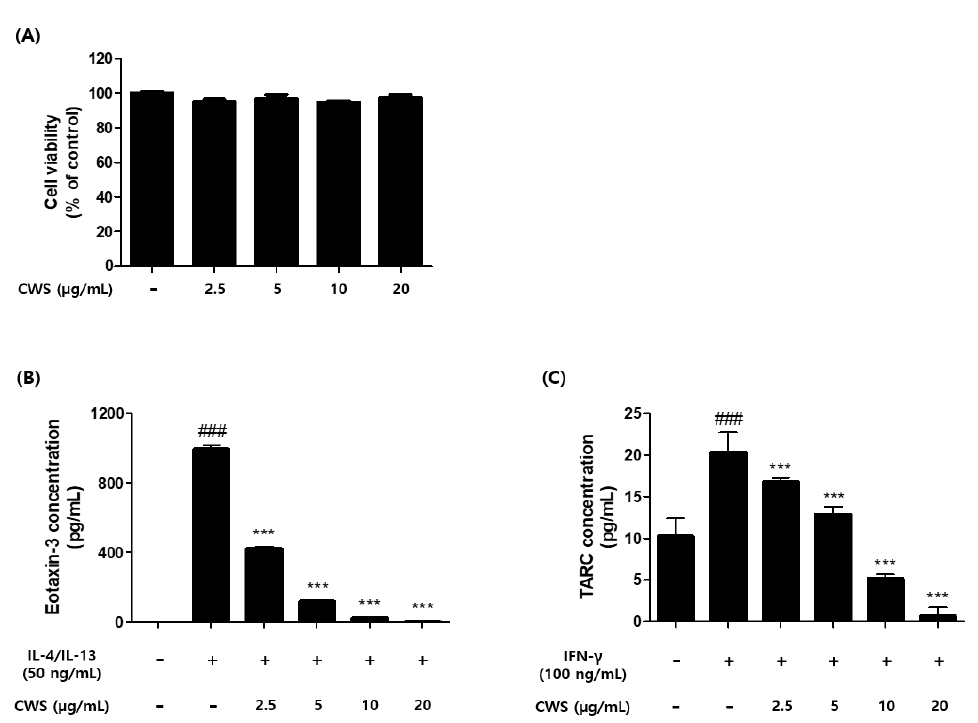
Figure 1. Effect of CWS treatment on AD chemokines in human keratinocytes (HaCaT cells). ( A ) Cell viability was measured after treatment of CWS (0, 2.5, 5, 10 and 20 µ g/mL) for 48 h. ( B ) HaCaT cells were treated with varying concentrations of CWS and induced with IL-4/IL-13 (50 ng/mL each). The production of eotaxin ‐ 3 in culture supernatants was measured by ELISA ( n = 3). ( C ) HaCaT cells were treated with varying concentrations of CWS and induced with IFN ‐γ (100 ng/mL). The production of TARC in culture supernatants was measured by ELISA ( n = 3). The data are expressed as the mean ± standard deviation ### p < 0.001 indicate a significant difference between the induced group and untreated control; *** p < 0.001 indicate a significant difference between the sample treatment group and induced group.